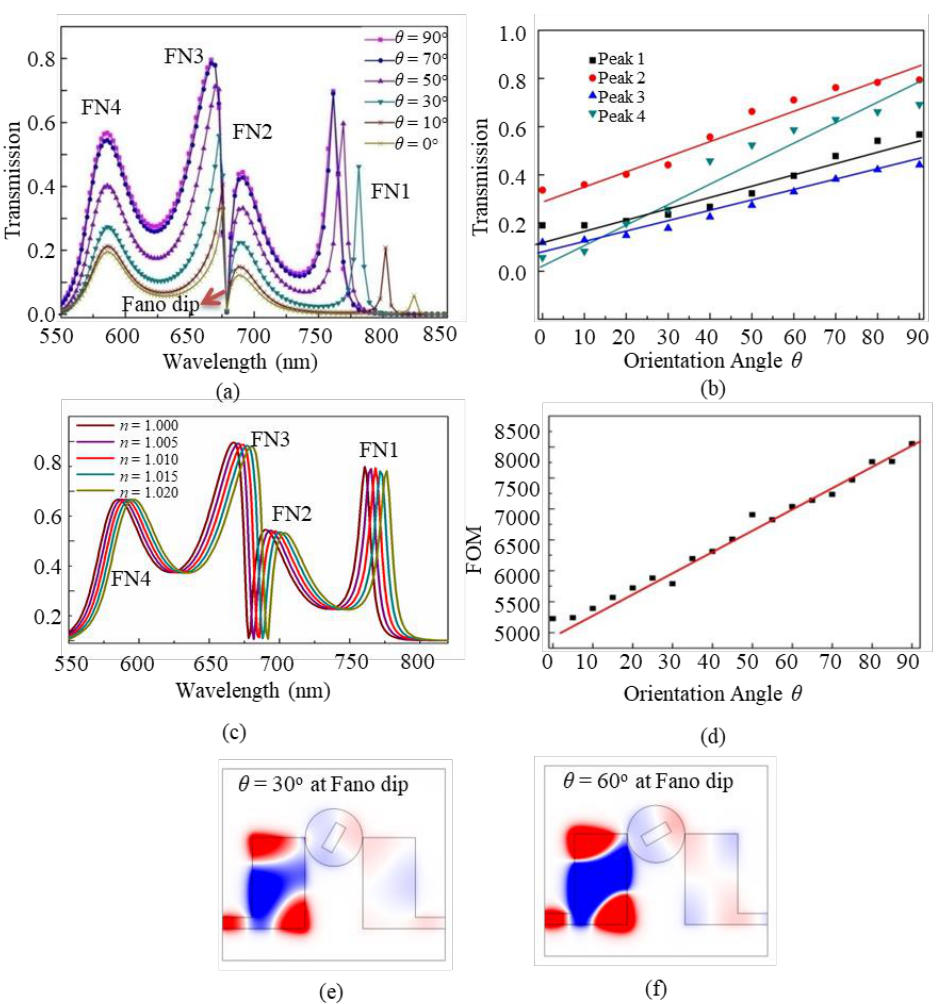
Figure 6. The influence of the orientation angle θ of the metal core on the transmission spectra ( a ), the aptitudes of the four Fano peaks ( b ), and the transmission related to the change of the refractive index at θ = 30° ( c ), and the FoM values for different θ ( d ), the H z distributions at the Fano dips for θ = 30° ( e ) and θ = 60° ( f ) .